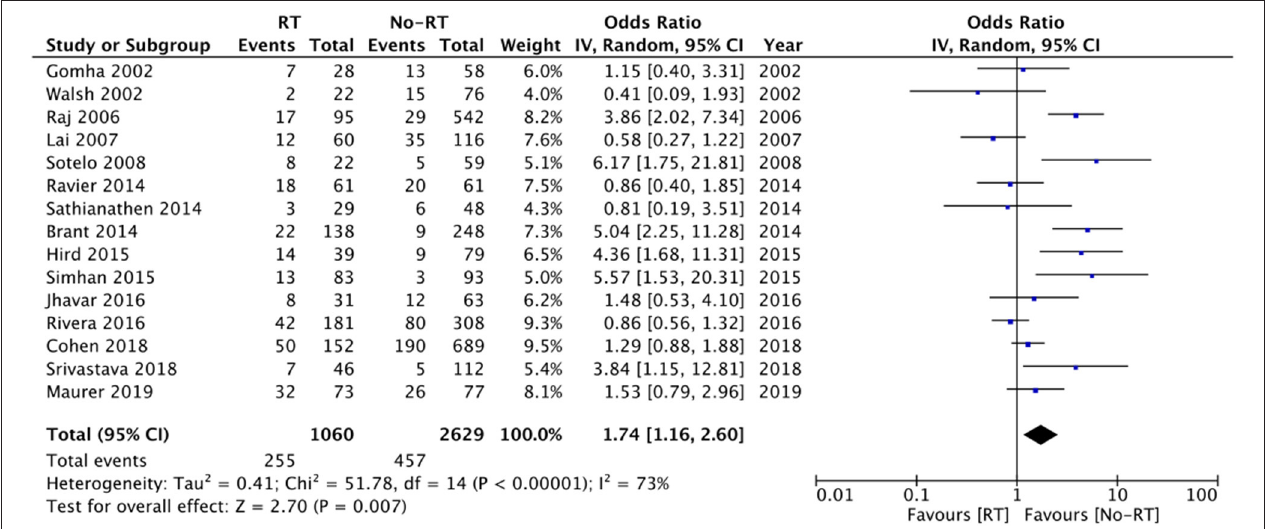
FIGURE 2 | Meta-analysis of no postoperative incontinence between RT and no-RT groups.